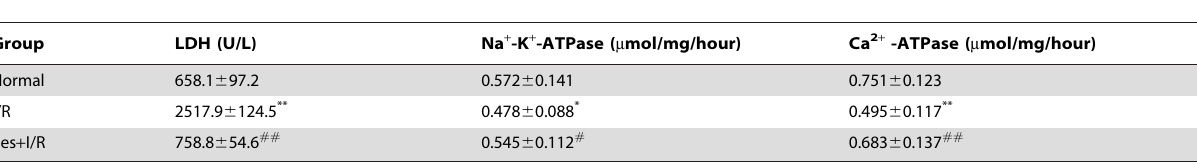
Table 1. Effect of Res on LDH, Na + -K + -ATPase and Ca 2 + -ATPase.